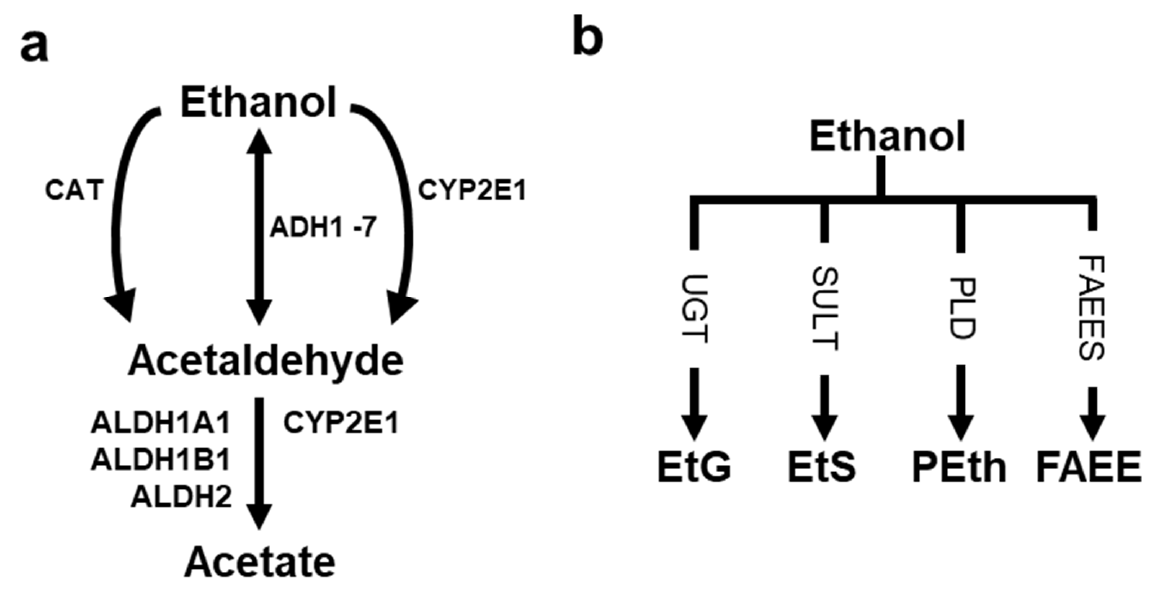
Figure 2. Schematic overview of ethanol metabolism. Ethanol can be metabolized by oxidative ( a ) or non-oxidative ( b ) pathways. ADH, alcohol dehydrogenase; ALDH, aldehyde dehydrogenase; CAT, catalase; CYP2E1, cytochrome P450 2E1; EtG, ethyl glucuronide; EtS, ethyl sulfate; FAEE, fatty acid ethyl ester; FAEES, fatty acid ethyl ester synthase; PEth, phosphatidyl ethanol; PLD, phospho- lipase D; SULT, sulfotransferase; UGT, UDP-glucuronosyltransferase. Modified from [9].